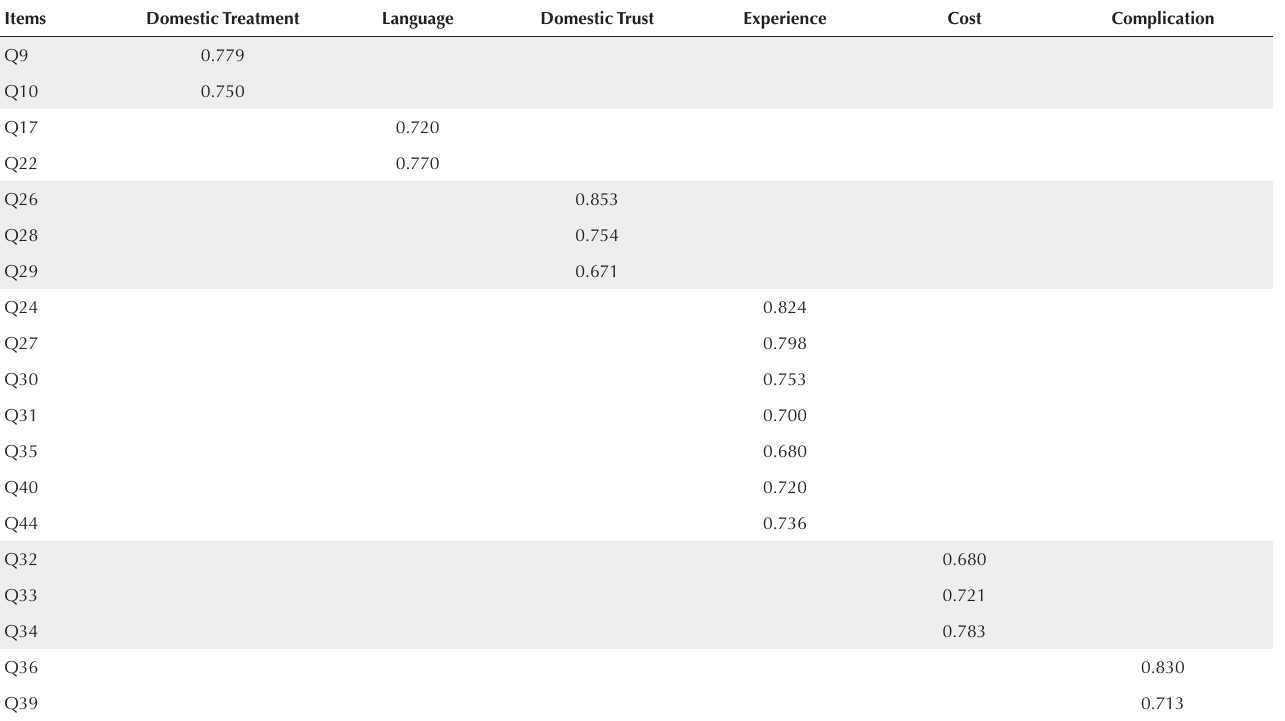
Table 1. Investigation of Unidimensionality of Each Factor Using Principal Component Analysis Items